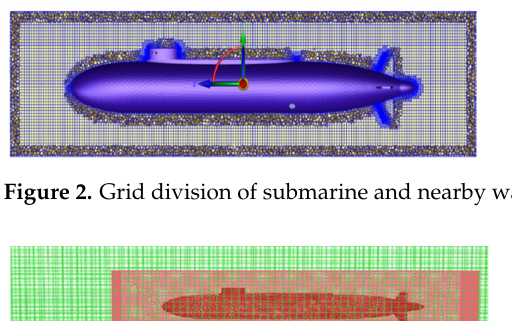
Figure 2. Grid division of submarine and nearby watershed.